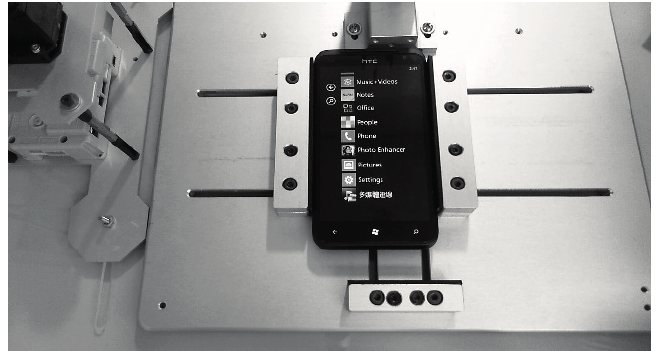
Figure 11. Using the L color space as the basis of the image operator.